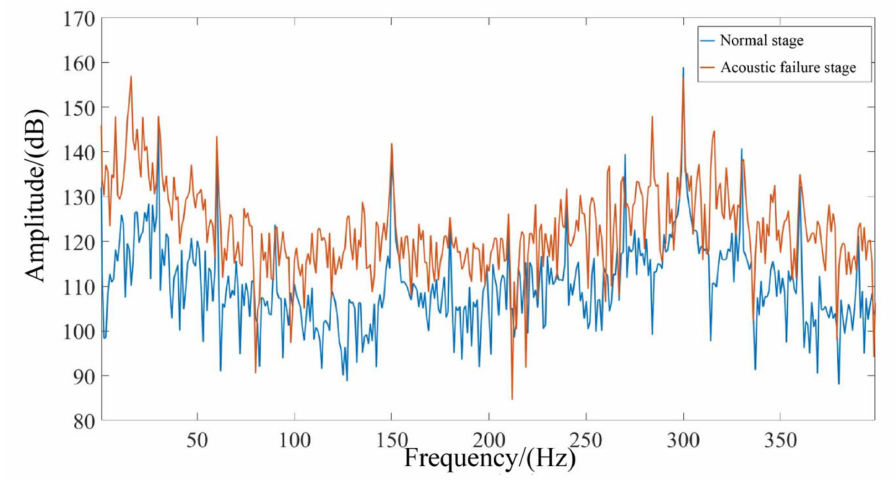
Figure 4. Comparison of frequency domain waveforms in different life stages of internal gear pumps.